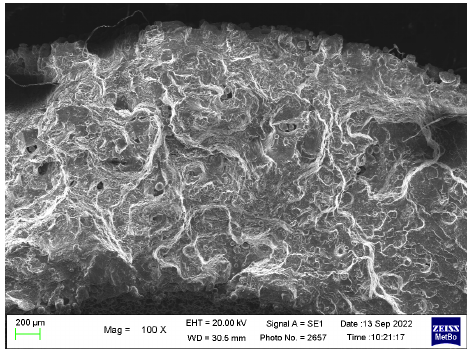
Figure 10. Final fracture surface of a 2.4 mm thick specimen as built